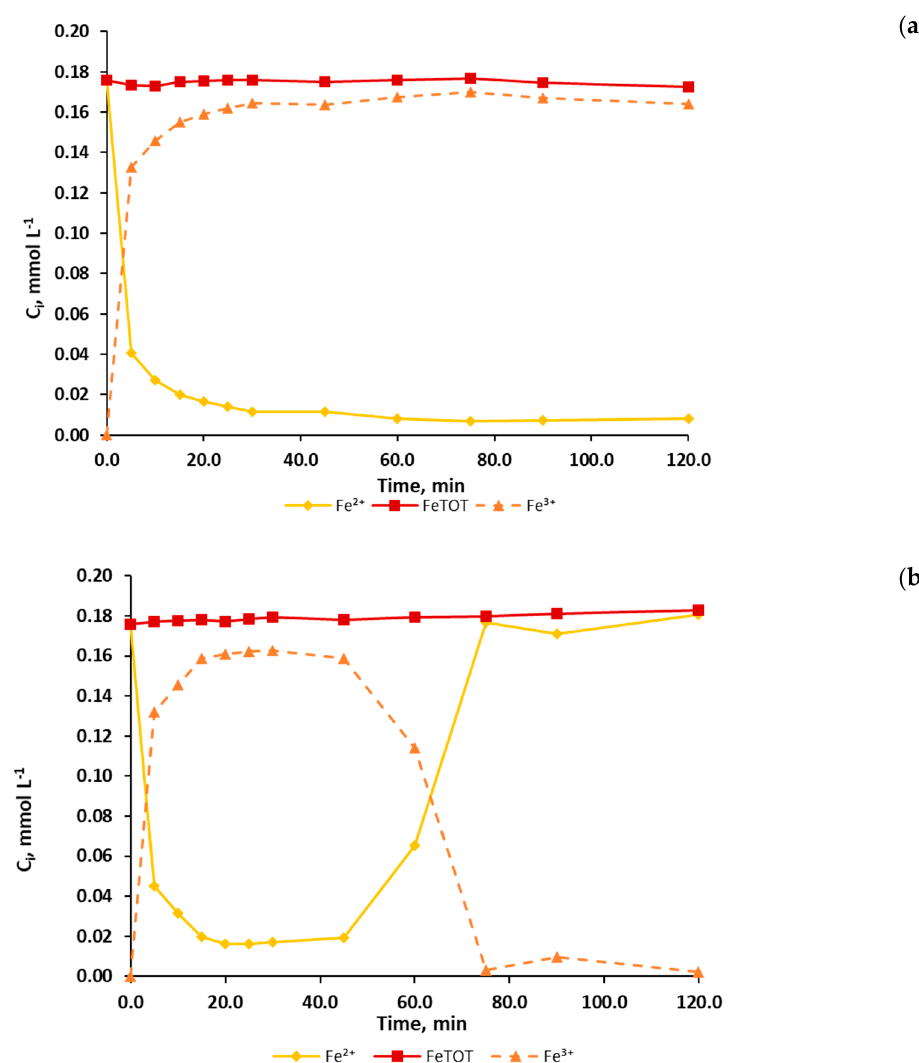
Figure 1. Evolution of the measured concentration of Fe 2+ ( ◊ , ♦ ) and total iron ( □ , ■ ) represented by a continuous line and of the calculated concentration of Fe 3+ ( ∆ , ▲ ), represented by a dashed line, during a) Fenton (empty symbols) and b) photo-Fenton (solid symbols ) experiments performed with high concentrations of the Fenton reagents.